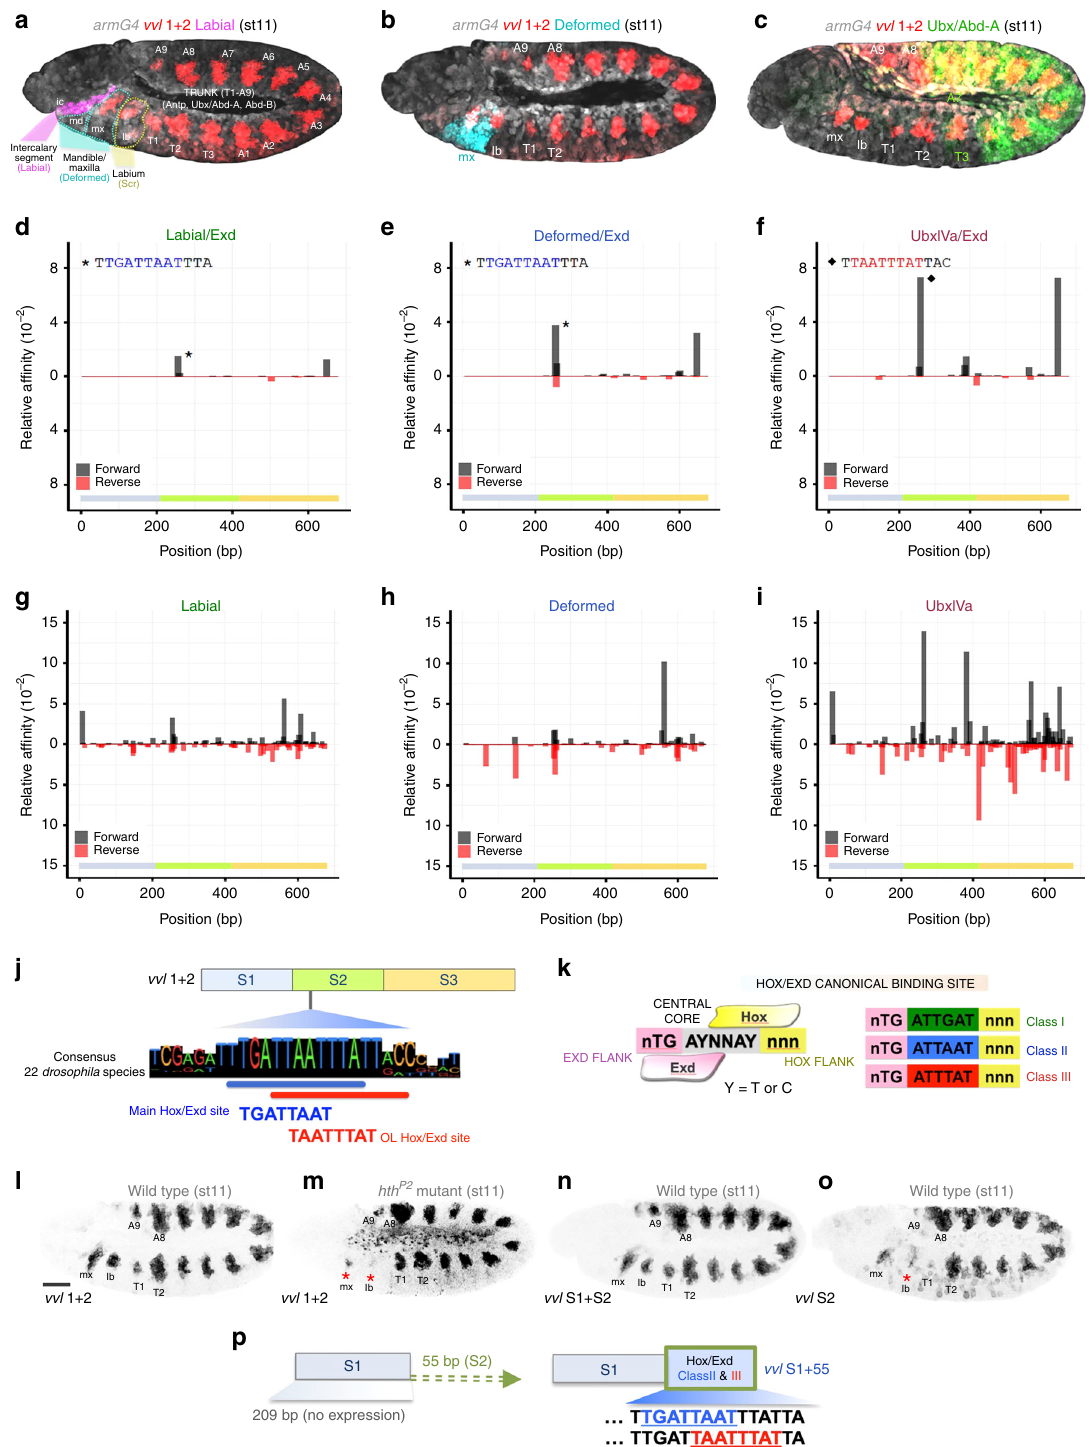
Fig. 1 Hox regulatory inputs in vvl1 + 2 CRM. a – c Spatial relation of vvl1 + 2 expression pattern (red) with respect to various Hox expression domains. a Labial (purple) is expressed in the intercalary segment, ( b ) Dfd (blue) is expressed in the mandible and maxilla, ( c ) Ubx and Abd-A (green) protein expression extends from T3 to A7. d – i In silico predicted relative af fi nity and localisation of Hox binding sites for Lab-Exd ( d ), Dfd-Exd ( e ), Ubx IVa-Exd ( f ), Lab monomer ( g ), Dfd monomer ( h ) or Ubx IVa isoform monomer ( i ) in vvl1 + 2 . ( j ) Scheme of vvl1 + 2 and the S1 , S2 and S3 sub-fragments showing the localisation of the main (blue) and overlapping (red) Hox-Exd sites. ( k ) Scheme of a canonical Hox-Exd binding site showing the central core bound by both proteins (grey), the Exd (pink) or Hox (yellow) bound fl anking sites, and the core sequences bound preferentially by class 1, 2 and 3 complexes. Expression of vvl1 + 2 in wild type ( l ) or hth P2 embryos effectively behaving as Exd mutants ( m ). Expression of the S1 + S2 fragment ( n ) or S2 ( o ) in wild type embryos. p Scheme showing the S1 and S1 + 55 constructs. a – c highlight the segments where each Hox protein is expressed: Lab in the intercalary (ic); Dfd in the mandible (md) and maxilla (mx); Scr in the labium (lb) and the fi rst thoracic (T1). Antp, Ubx, Abd-A and Abd-B are expressed in the (T1-A9) thoracic (T) and abdominal (A) trunk segments (only Ubx and Abd-A expression are shown in c ). Embryos in a – c were expressing UAS-lacZ with the arm-Gal4 line to label all cells in grey. In panels d-i the coloured horizontal bar represents the extension of the S1 (grey), S2 (green), and S3 (orange) sequences. Scale bar 50 μ m NATURE COMMUNICATIONS| (2019) 10:3597